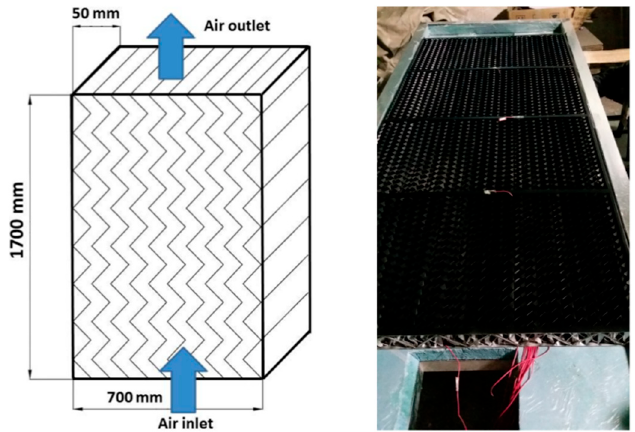
Figure 3. Structure of the corrugated packing.